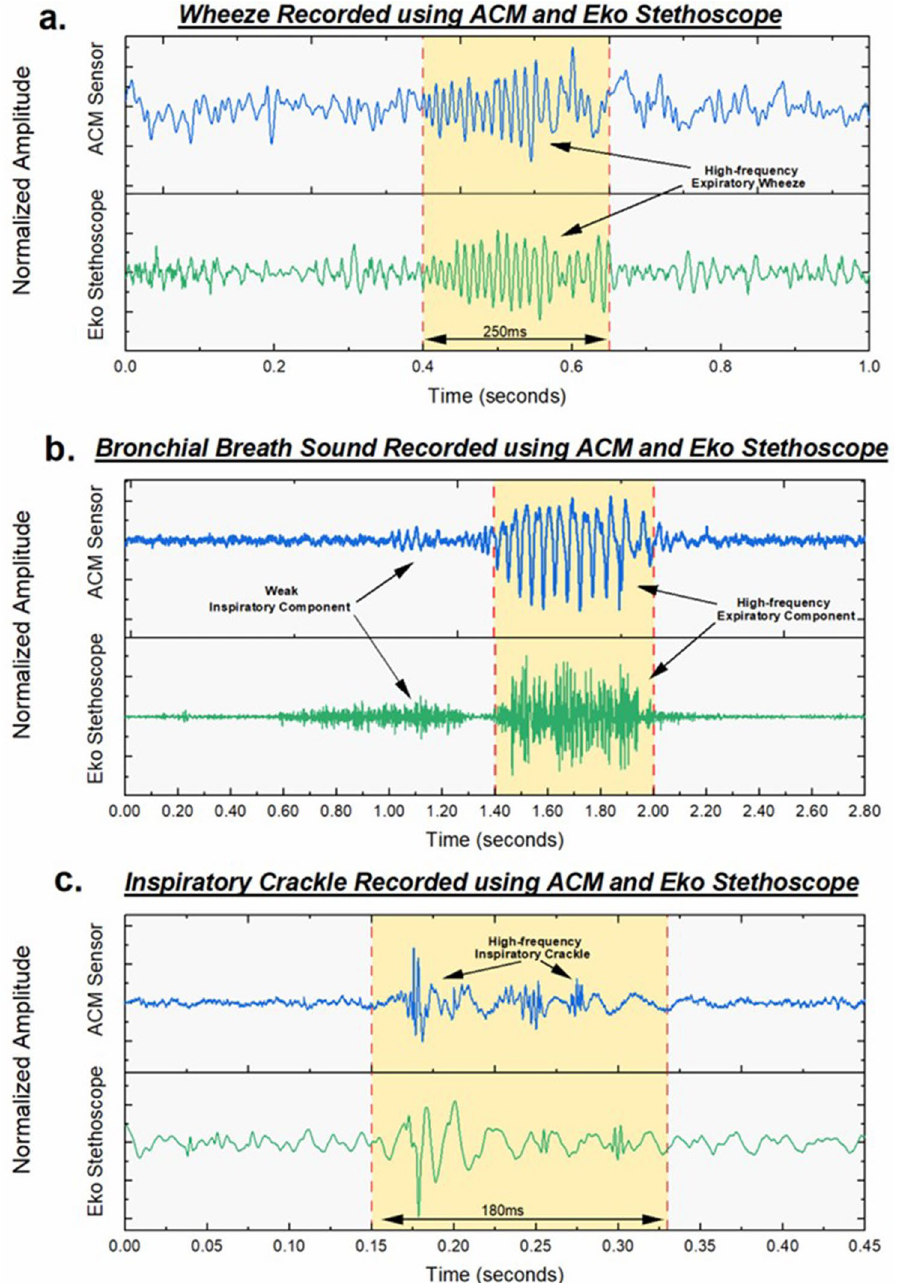
Figure 3. Comparison of ACM performance with Eko digital stethoscope. ( a ) Signal waveforms of expiratory wheeze captured using ACM sensor and digital stethoscope indicating a time duration of 250 ms. Signal exhibits sinusoidal characteristic. ( b )Signal waveforms of expiratory bronchial breath sounds exhibiting loud, high frequency signals. c Signal waveforms of inspiratory crackle exhibiting short bursts of high frequency signals with a total duration of 180